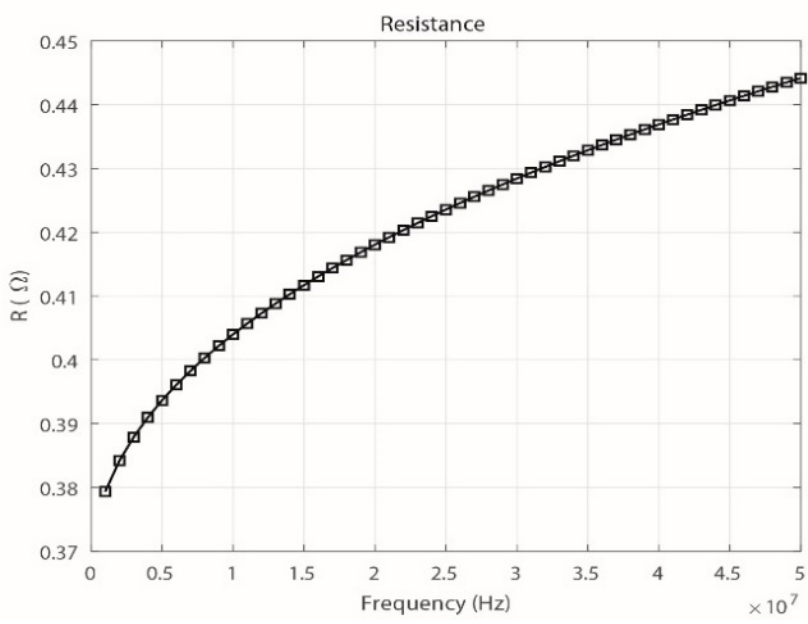
Figure 3. Theoretical behavior of R with increasing frequency of the signal.